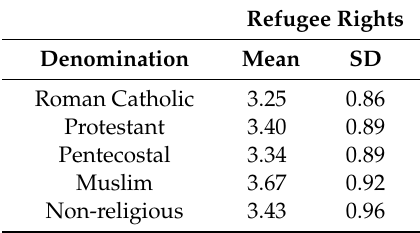
Table 1. Mean and standard deviation (SD) of attitudes towards refugee rights by denomination.